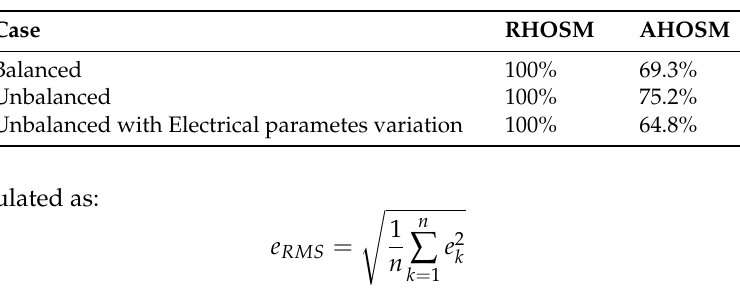
Table 2. Zero crossing number (%).